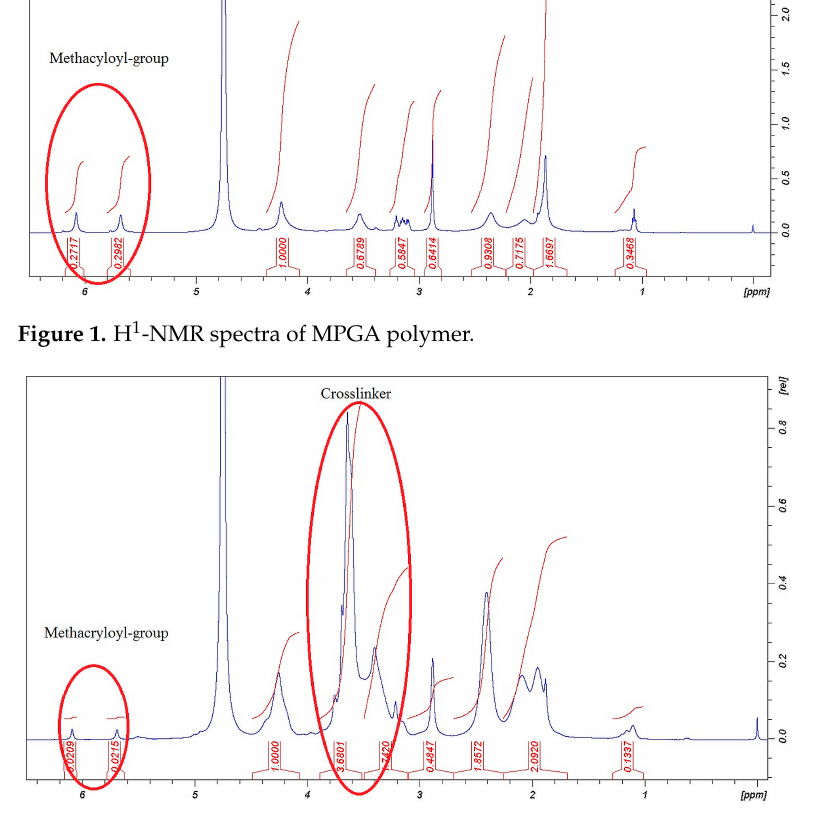
Figure 2. H 1 -NMR spectra of PGA-MNP polymer.